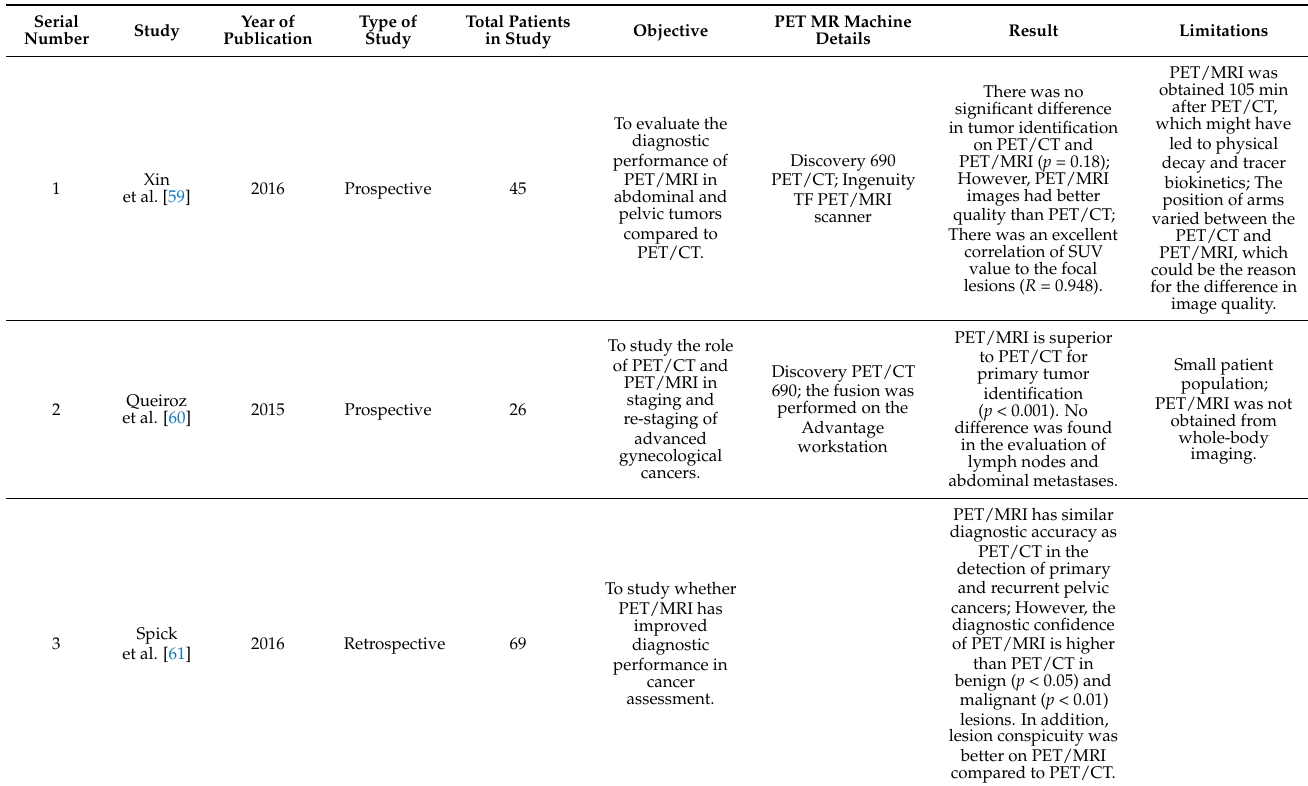
Table 4. Characteristics of PET/MRI studies in pelvic